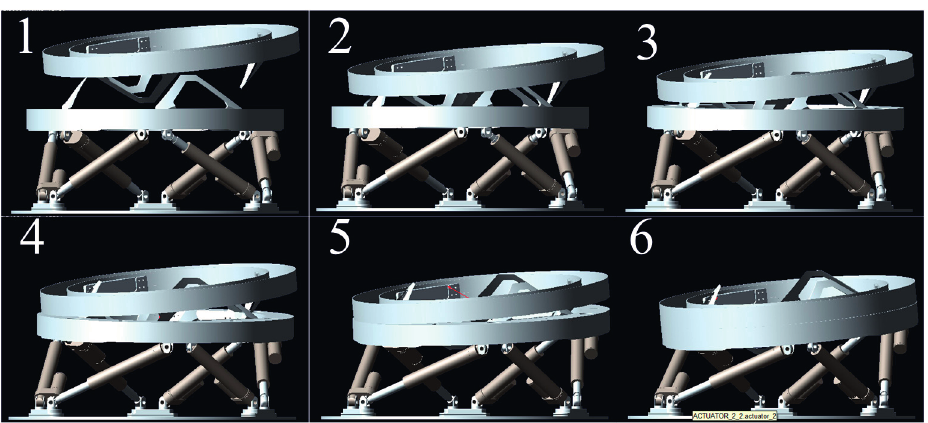
Figure 17. The docking process of Case 4.